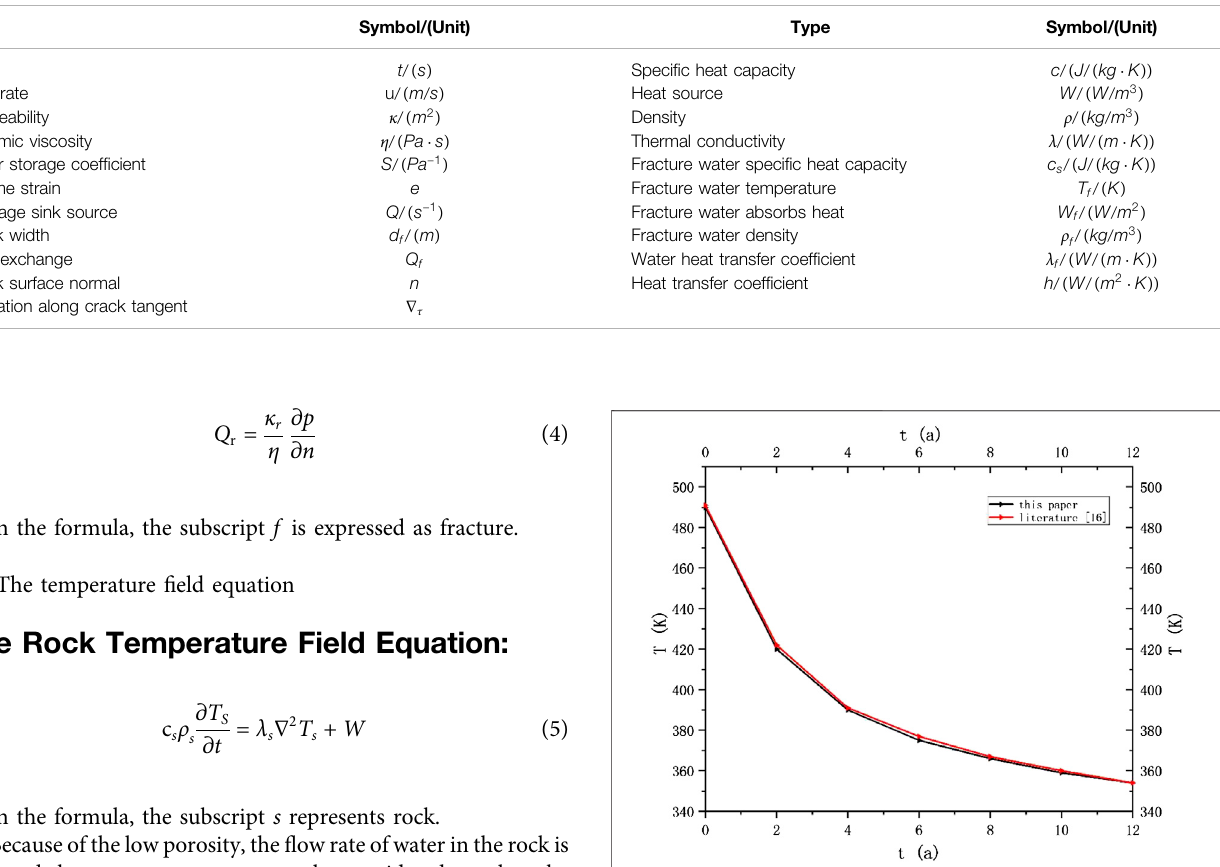
TABLE 1 | Control equation parameters.